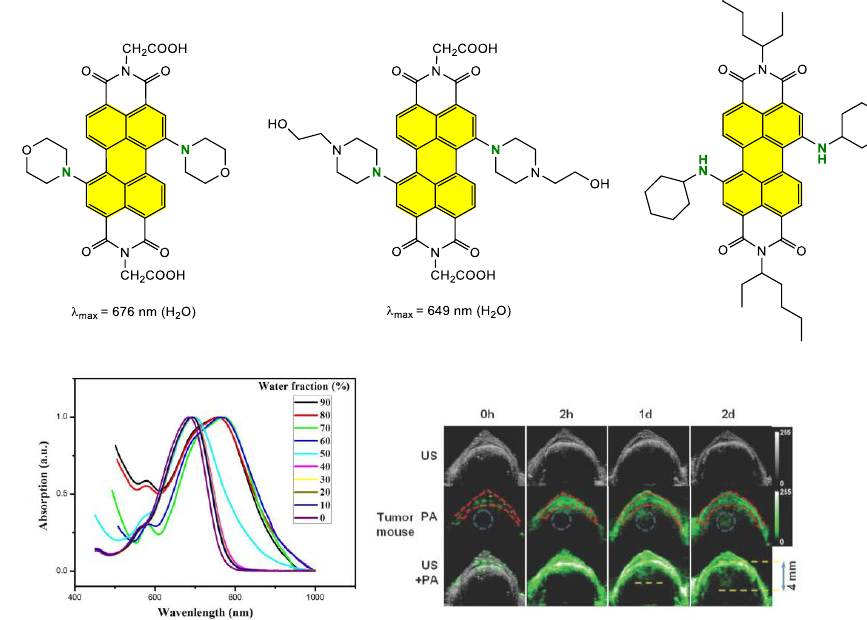
Figure 18. Structures of 1,7-bis-morpholino, 1,7-bis-piperidino and 1,7-bis-cyclohexylamino PDI; normalized absorption spectra of 1,7-bis-cyclohexylamino PDI in THF/water mixtures with different volume ratios; photoacoustic imaging and ultrasound imaging in the skull and tumour region in brain-bearing mice of 1,7-bis-cyclohexylamino PDI NPs. The dashes are used to delineate (red) and measure (yellow) the size of the tumour. Reprinted with permission from Ref. [124]. Copyright 2015 Wiley-VCH GmbH.